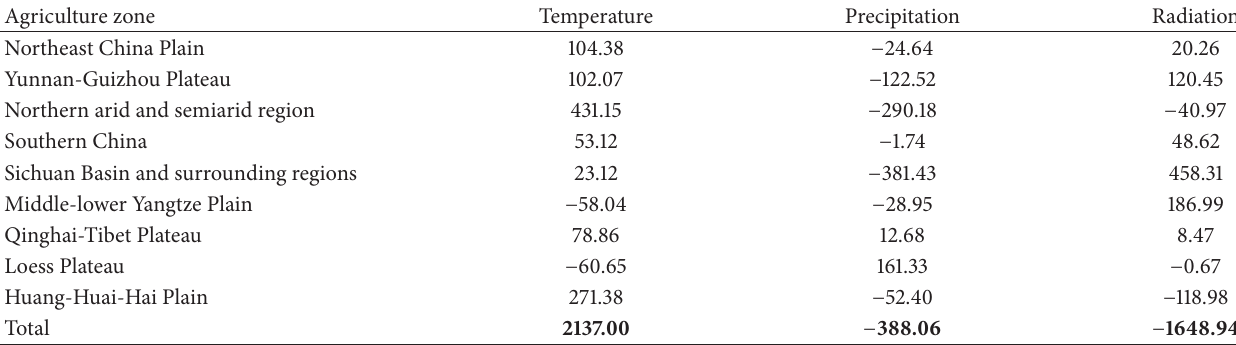
Table 1: Contributions of climatic factors to the production potential in various regions of China